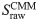
The effect of co-conservation and co-evolution on the interface prediction.Left: The fraction of proteins for which a near-native decoy is in the top scored predictions, as a function of the number of decoys considered, for the S(SRP, SN, Sent) (grey solid line), S(SRP, SN, Sent, SCMM (black solid line), S(SRP, SN, Sent, SCT (grey dashed line), S(SRP, SN, Sent, SCT, SCMM) (black dashed line) and SrawCMM (light grey dash-dotted line) scoring functions. Right: The number of proteins for which the rank of the top near-native prediction is within the top 1, 5 or 10 predictions, for the S(SRP, SN, Sent) (solid black bars), S(SRP, SN, Sent, SCMM (solid grey bars), S(SRP, SN, Sent, SCT (dark checked bars) and S(SRP, SN, Sent, SCT, SCMM) (light checked bars) scoring functions.